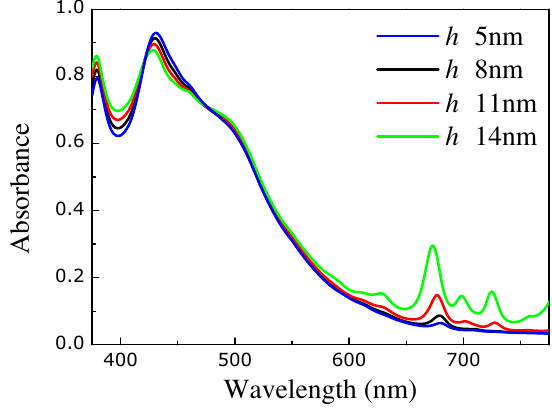
Figure 6. Absorbance of normally incident light on the array of nanocubes described in Figure 2 separated from a 50 nm gold substrate by a polyelectrolyte film for different thicknesses, i.e. , h = 5 , 8 , 11 , 14